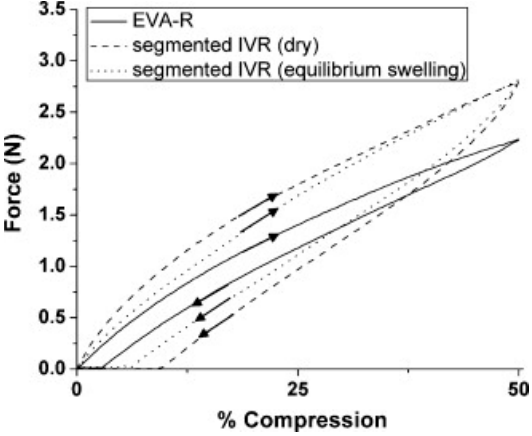
Figure 7. Force versus percent ring compression for experimental (segmented IVR) and Nuvaring ® (EVA-R) intravaginal rings. Equilibrium swelling, as determined by mass change, was achieved after 3 days in water. Each ring was brought to 50% compression and subsequently allowed to recover to its original diameter as indicated by the direction of arrows. Adapted from [14], Elsevier, 2010 with permission.